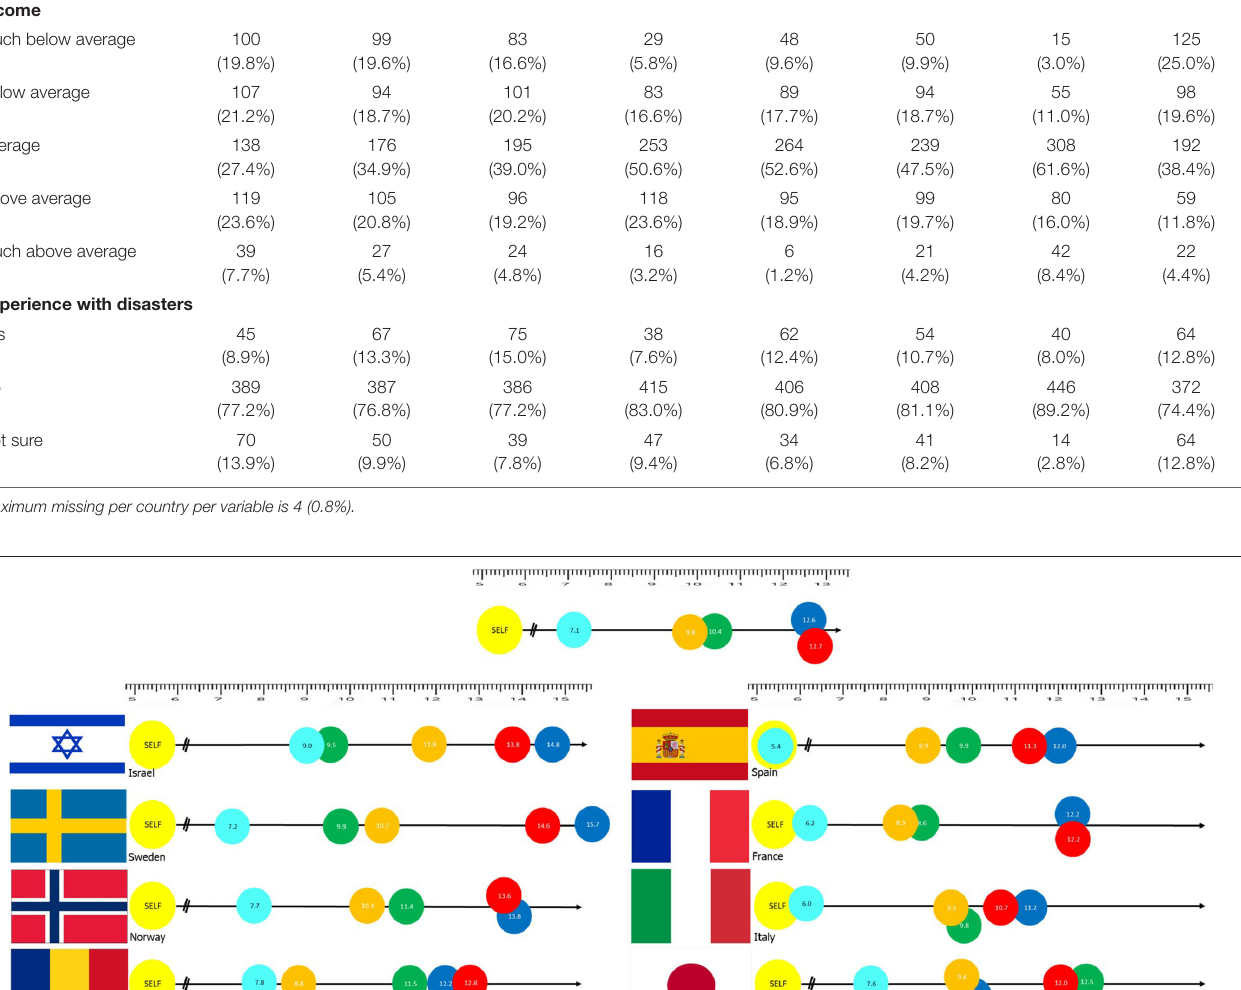
risks. For instance, Millennials view the risk posed by natural hazards and extreme weather more seriously than Generation Z and boomers. Younger participants view social disturbance more seriously than older participants. See complete data in Figure 2